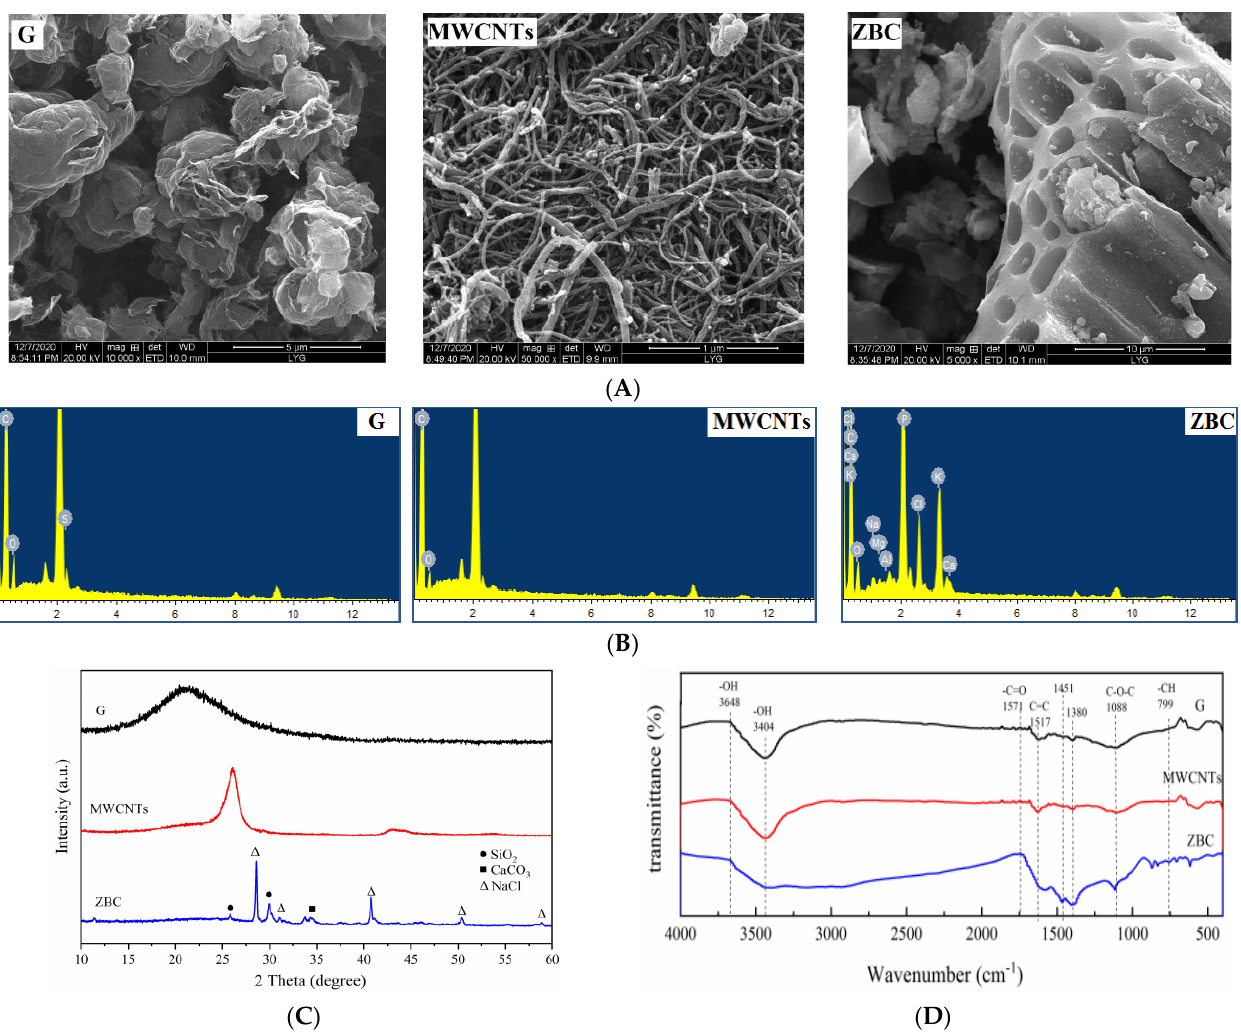
Figure 1. ( A ) SEM, ( B ) EDS (Full scale 1282 cts cursor:0.000 ), ( C ) XRD, and ( D ) FTIR results for G, MWCNTs, and ZBC. G: graphene; MWCNTs: multi-walled carbon nanotubes; ZBC: biochar derived from a wetland plant (Thalia dealbata Fraser).